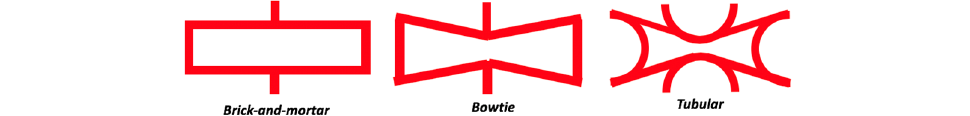
Figure 5. A process of creating cementitious composites reinforced with 3D printed reinforcement (author’s photos).